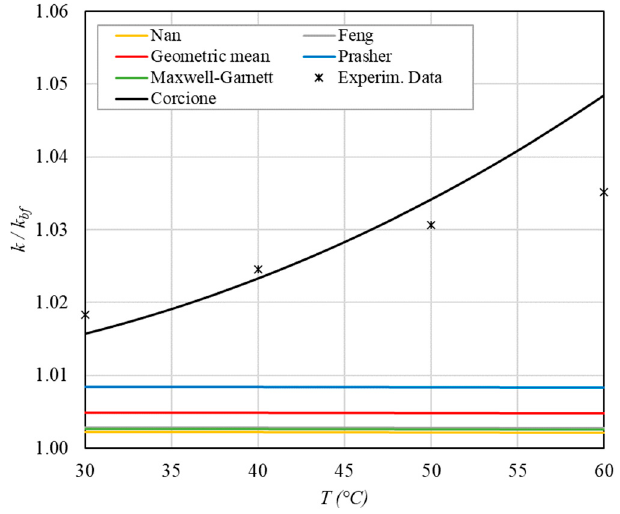
Figure 6. Increase in thermal conductivity versus temperature for ϕ = 0.09%.